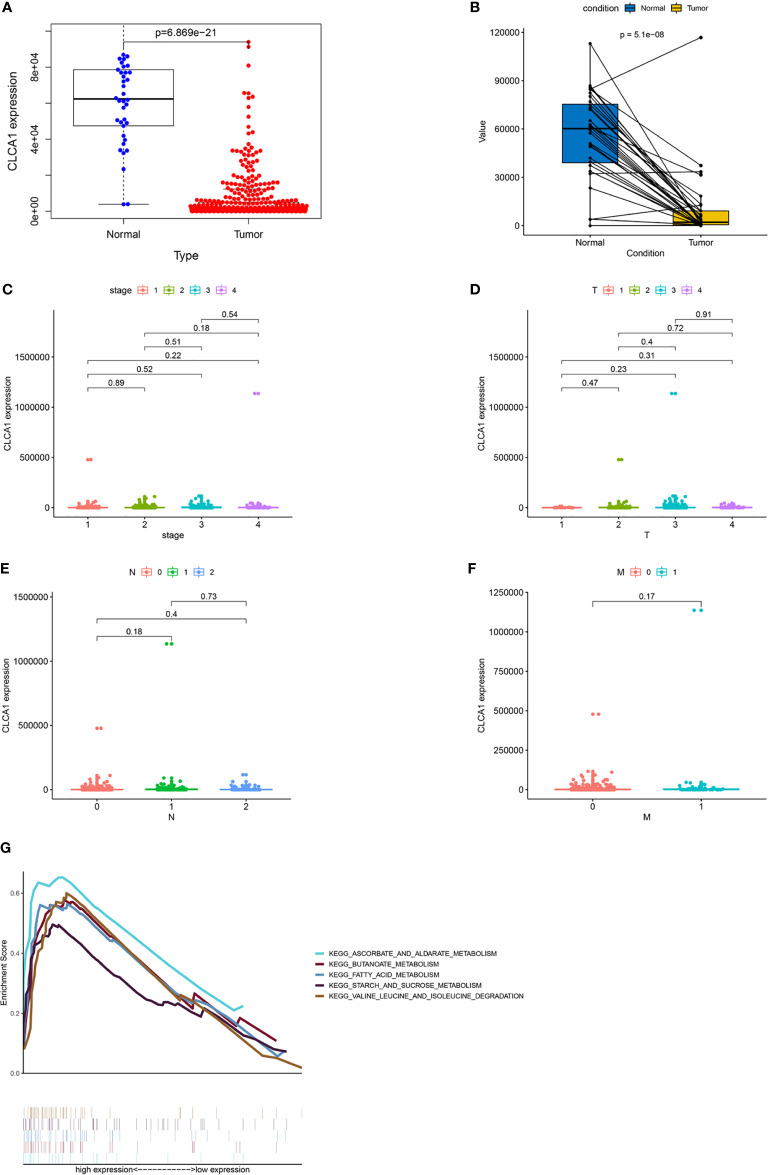
Visualization of correlations between CLCA1 expression levels and clinical features. GSEA of CLCA1. (A) Differences in CLCA1 expression between control tissues and CRC tissues. (B) Differential expression of CLCA1 between tumor tissues and adjacent tissues. (C) Differences in CLCA1 expression between different clinical stages. (D) Differences in CLCA1 expression between different T stages. (E) Differences in CLCA1 expression between different N stages. (F) Differences in CLCA1 expression between different M stages. T, tumor; N, regional lymph node; M, metastasis. (G) GSEA for CLCA1. GSEA, Gene set enrichment analysis.